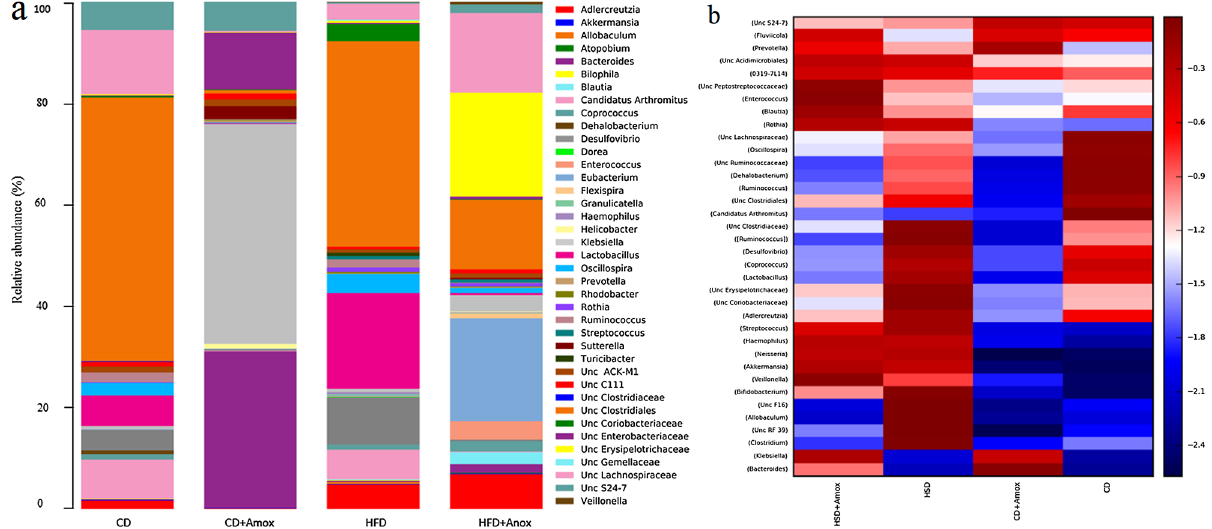
Figure 7. Bar chart ( a ) and heat map ( b ) showed the short-term effect of a high-salt diet (4% in chow) on the relative abundance of the most represented bacterial taxa at the genus level for each sample. Amoxicillin- treatment in HSD-fed mice found a significant decrease in Lactobacillus, Streptococcus , Unc Clostridiaceae , Clostridium , [Ruminococcus] , Unc Erysipelotrichaceae , Allobaculum , Desulfovibrio , Unc Coriobacteriaceae , Unc F16 and a significant increase in Bacteroides and Akkermansia . The color intensity in each sample is normalized to represent its relative ratio in the four groups. The color scale of higher (dark red) and lower (dark blue) shows the relative abundances of top 36 mean abundance of bacterial communities. CD: Standard—chow diet for 3 weeks; CD + Amox: Standard—chow diet for 3 weeks and subjected to Amoxicillin treatment in 3rd week; HSD: High-salt diet for 3 weeks; HFD + Amox: High-salt diet for 3 weeks and subjected to Amoxicillin treatment in 3rd week.